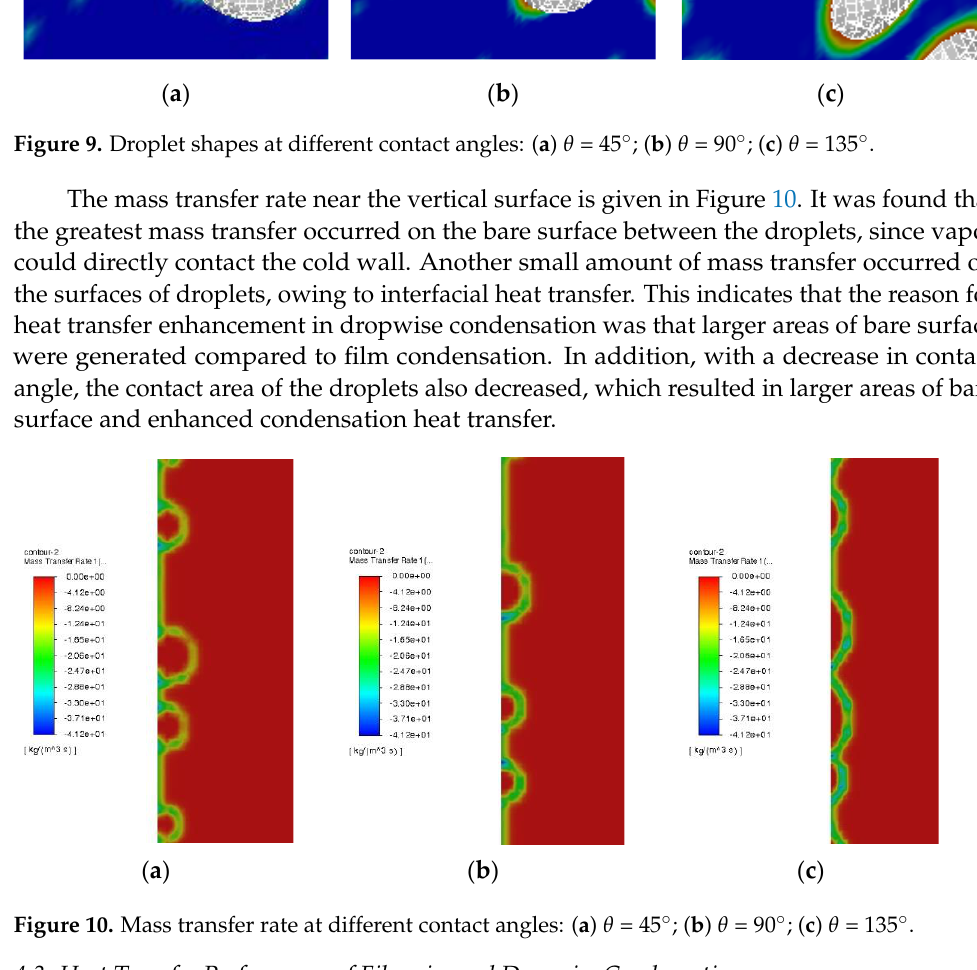
Table 3. Comparison of heat transfer coefficients between filmwise condensation and dropwise con- densation.